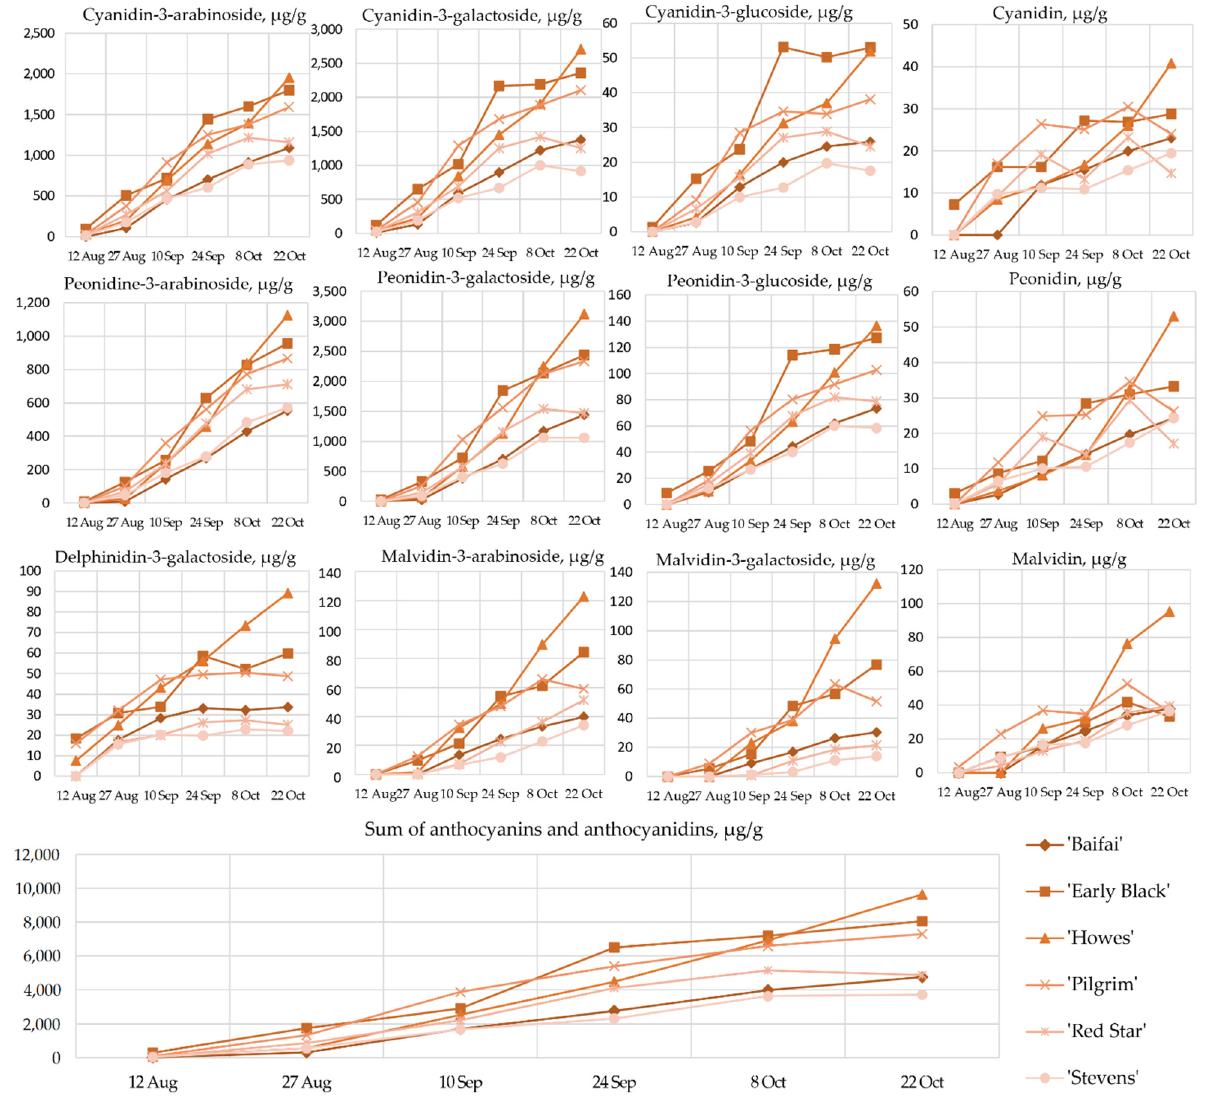
Figure 1. Variability of the qualitative and quantitative composition of anthocyanins and anthocyani- dins in fruit samples of large cranberry cultivars during